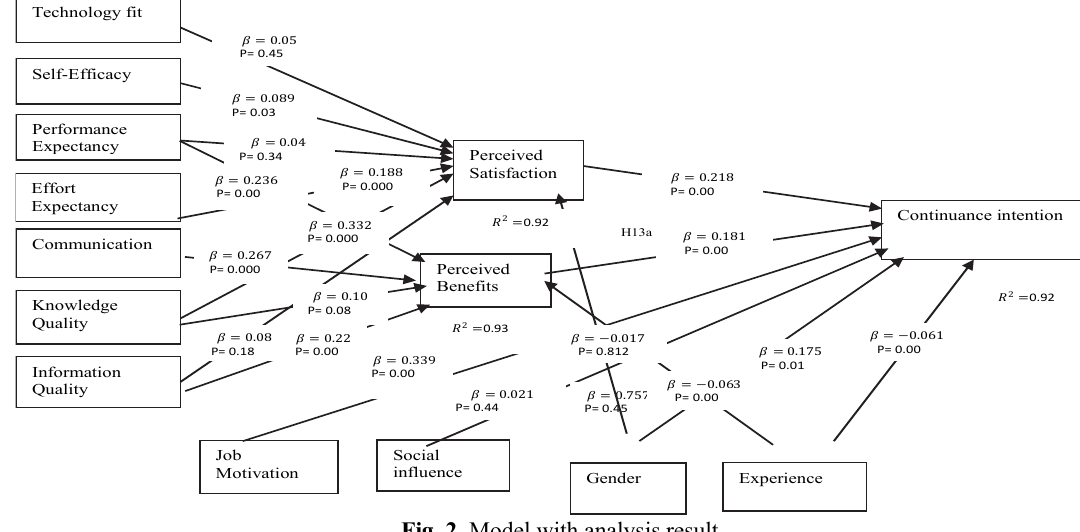
Fig. 2. Model with analysis result